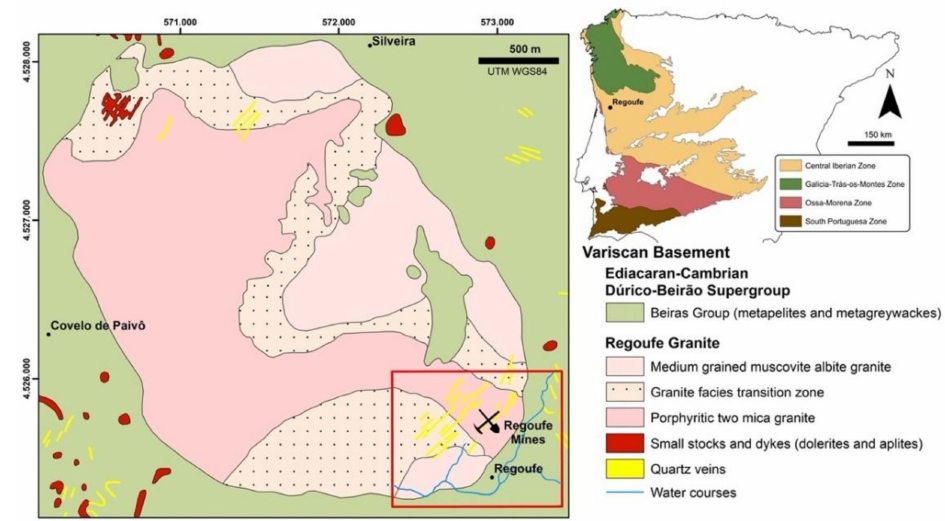
Figure 1. Location and geological sketch map of the Regoufe massif (modified from Vriend et al. [23]). Inset on the right was modified from Jacques et al. [27].